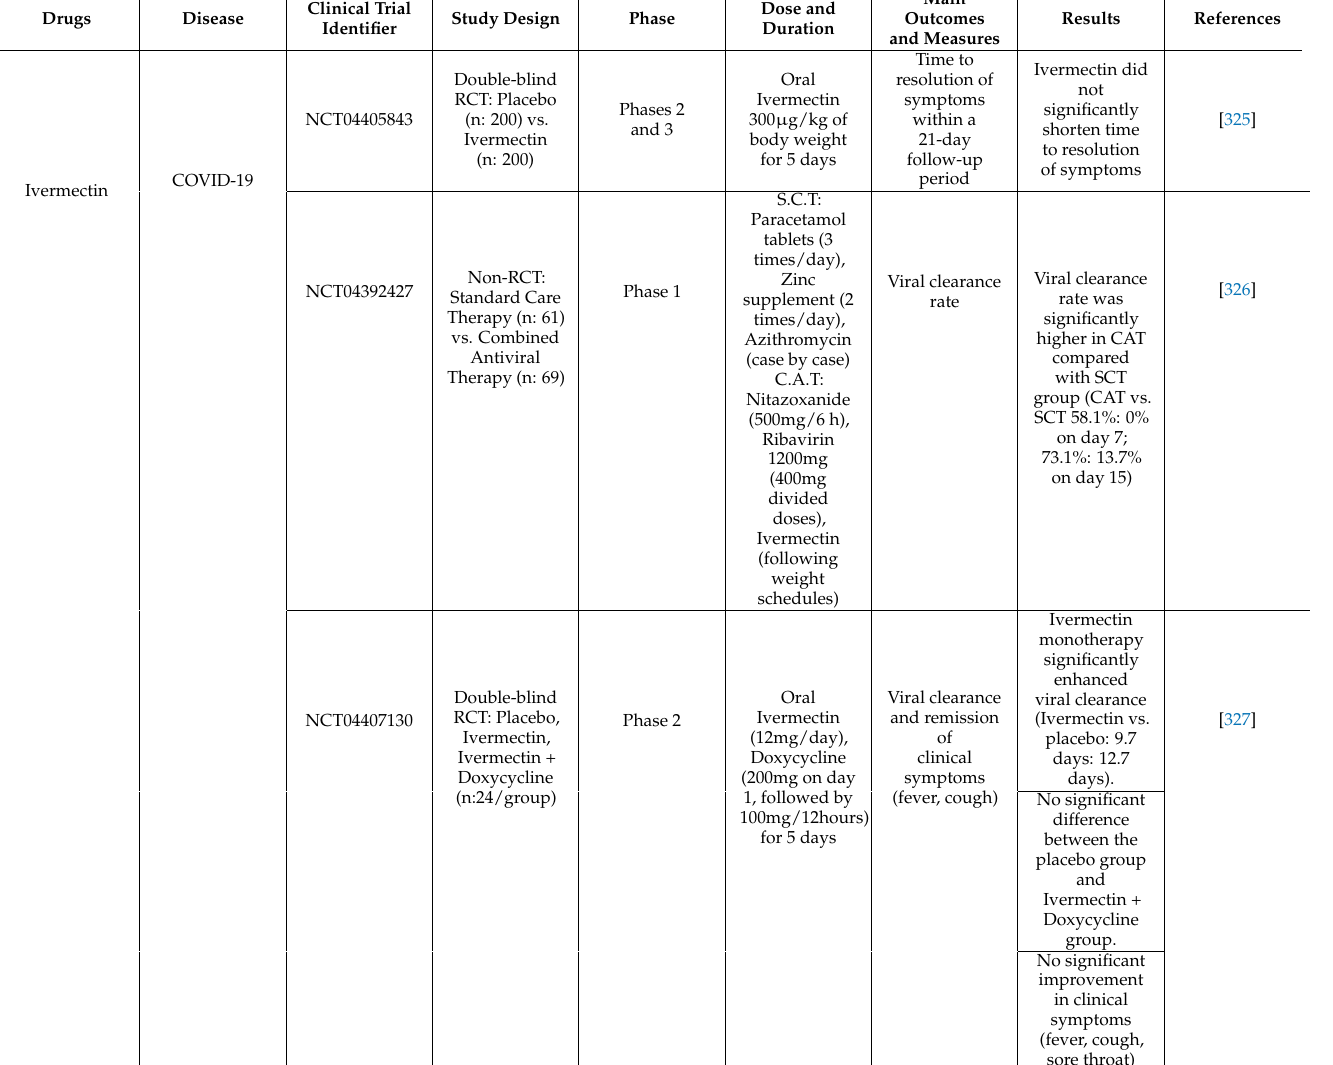
Table 4. Clinical Trials of Various Nuclear Transport Inhibitors in Treating Viral